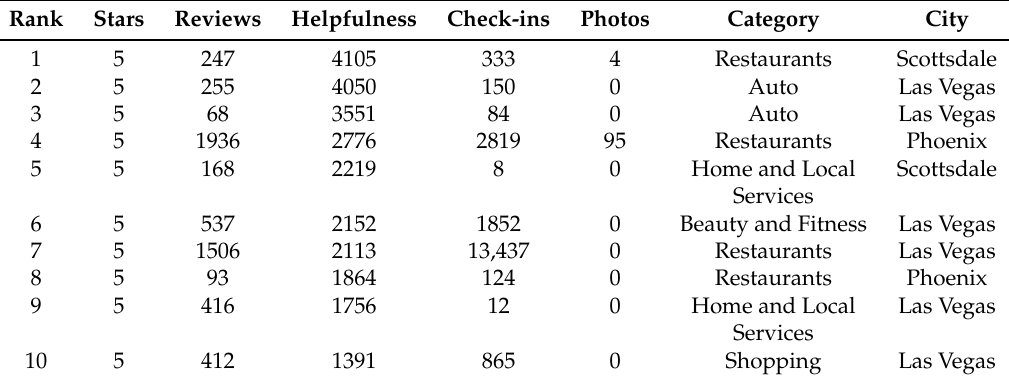
Table 5. Top 10 5-star businesses by cumulative